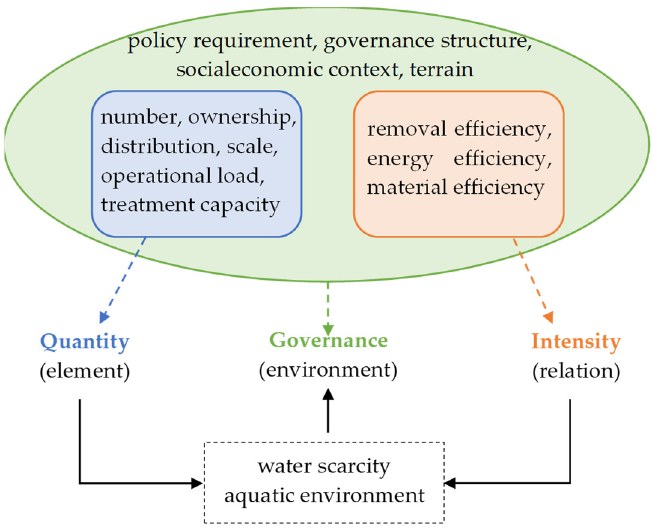
Figure 1. The quantity-intensity-governance framework for analyzing local wastewater treatment and reuse.